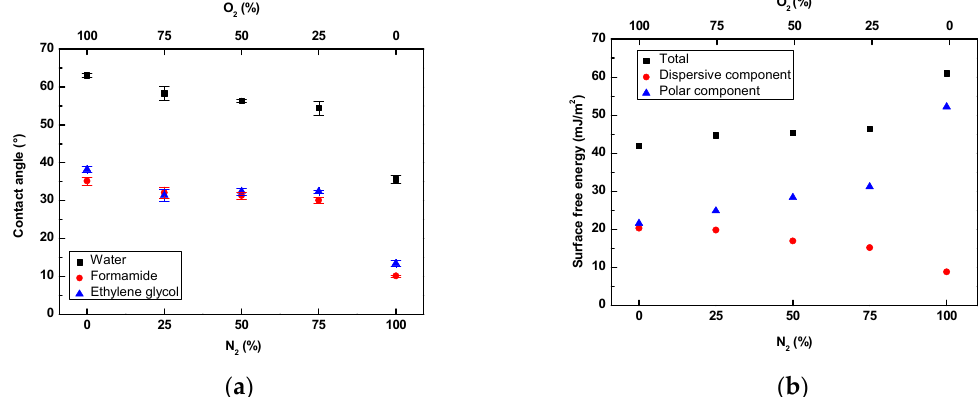
Figure 3. ( a ) Contact angle of water and ( b ) the surface free energy as a function of gas concentration for PU treated using N 2 /O 2 plasma for 180 s.